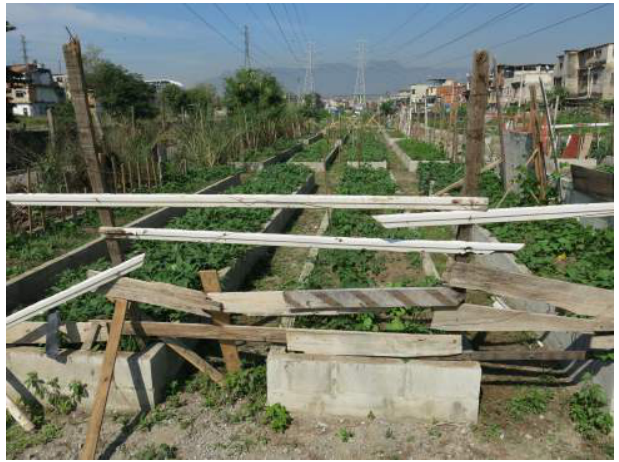
Figure 5. Hortas Cariocas organic food garden in Manguin- hos,